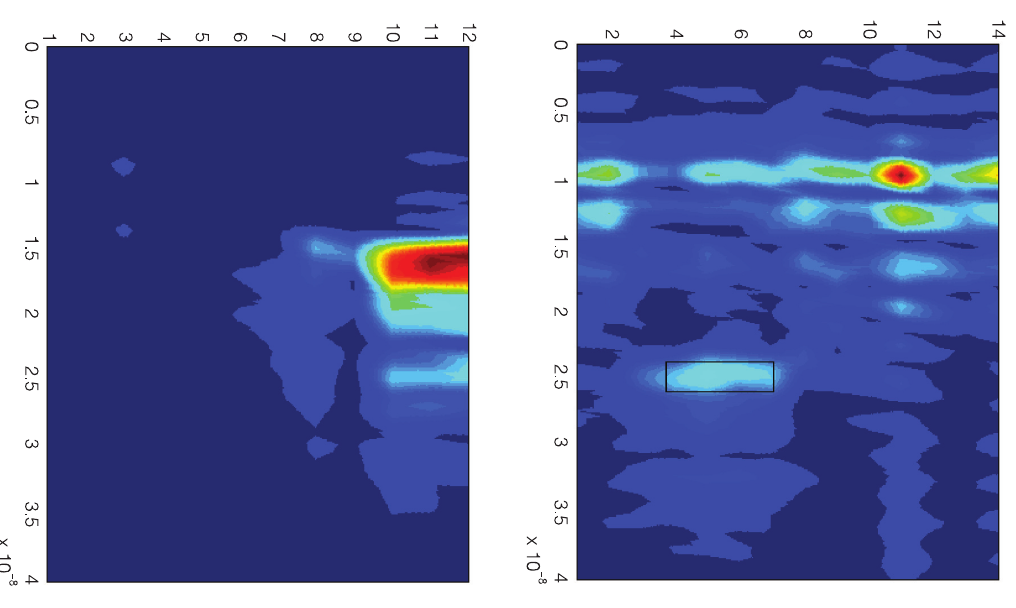
Fig. 3. Image of a metal sheet at 50 cm of depth in ungated mode. Linear common offset (distance between the gaps of 55 cm). Wideness of the sheet of 1 m. Frequency band of 200-800 MHz. Frequency step of 2 MHz. The abscissa is the number of scan with spatial step 20 cm. The ordinate is the return time in seconds.